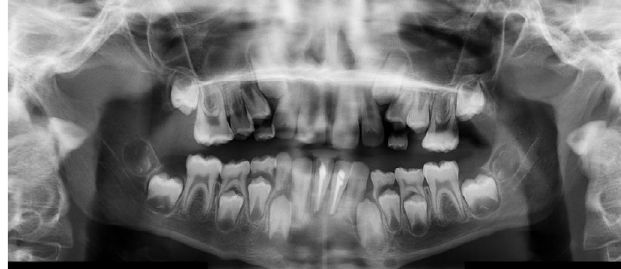
Fig. 6. Orthopantomogram 6 months after surgery. Ossi fi cation of the cavity left